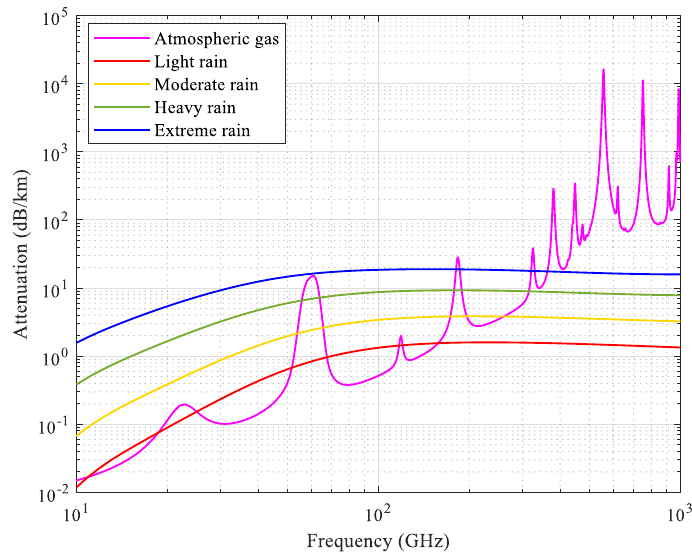
Figure3. Atmosphericgasandrainattenuationvariationwithfrequencies(figurecollectedfrom[54,55]). Figure 3. Atmospheric gas and rain attenuation variation with frequencies (figure collected from [54,55]).